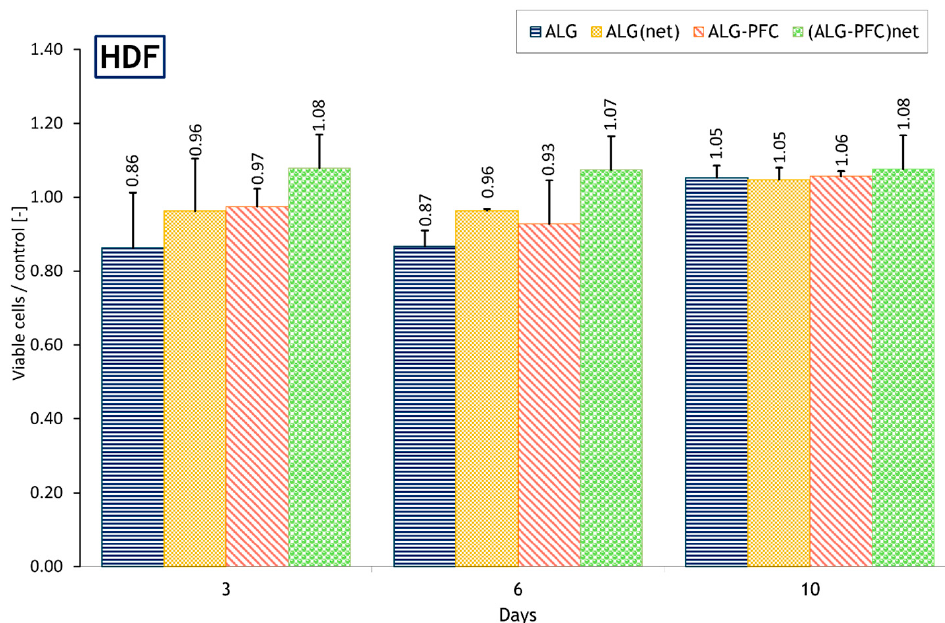
Figure 1. The ratio relative to the control of the percentage of viable HDF cells over 10 days of culture in the absence of patches (control) or the presence of modified patches. Key to the symbols: ALG—alginate, ALG net —alginate cross-linked, ALG-PFC—alginate–perfluorooctyl, (ALG-PFC) net — alginate–perfluorooctyl cross-linked. The values are presented as mean ± SD ( n = 6).